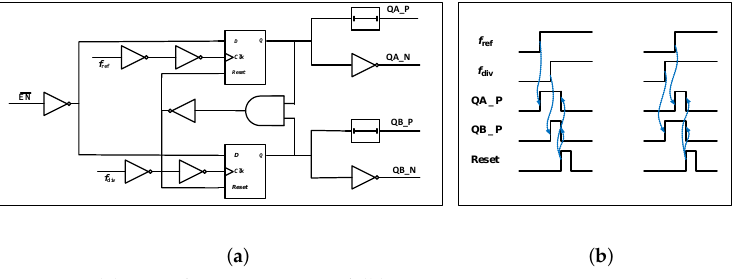
Figure 11. ( a ) PFD design circuit and ( b ) timing.